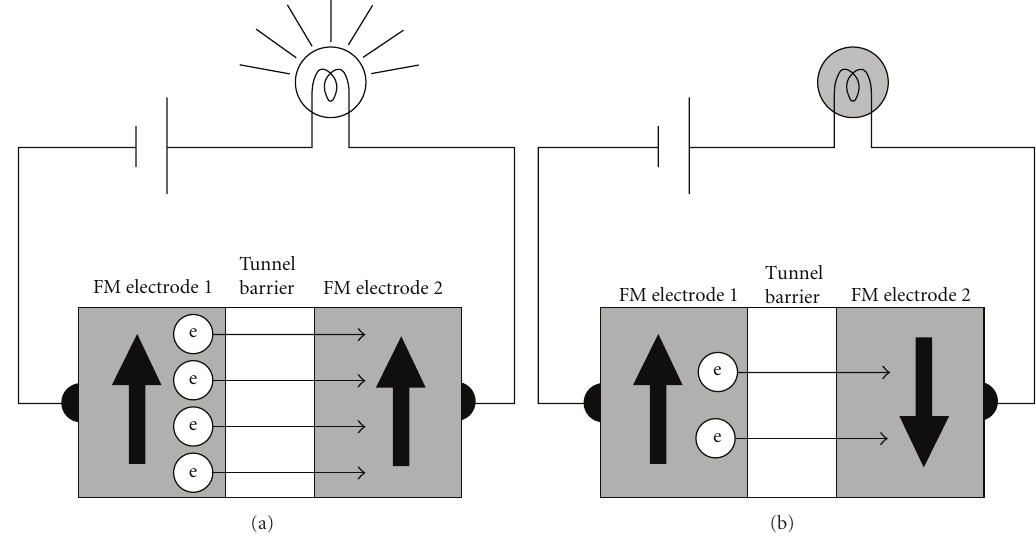
Figure 7: Schematic description of tunneling magnetoresistance e ff ect in a magnetic tunnel junction. Spins in the two electrodes are aligned (a) parallel and (b) antiparallel. Figures were reproduced with permission from Yuasa and Djayaprawira [56].